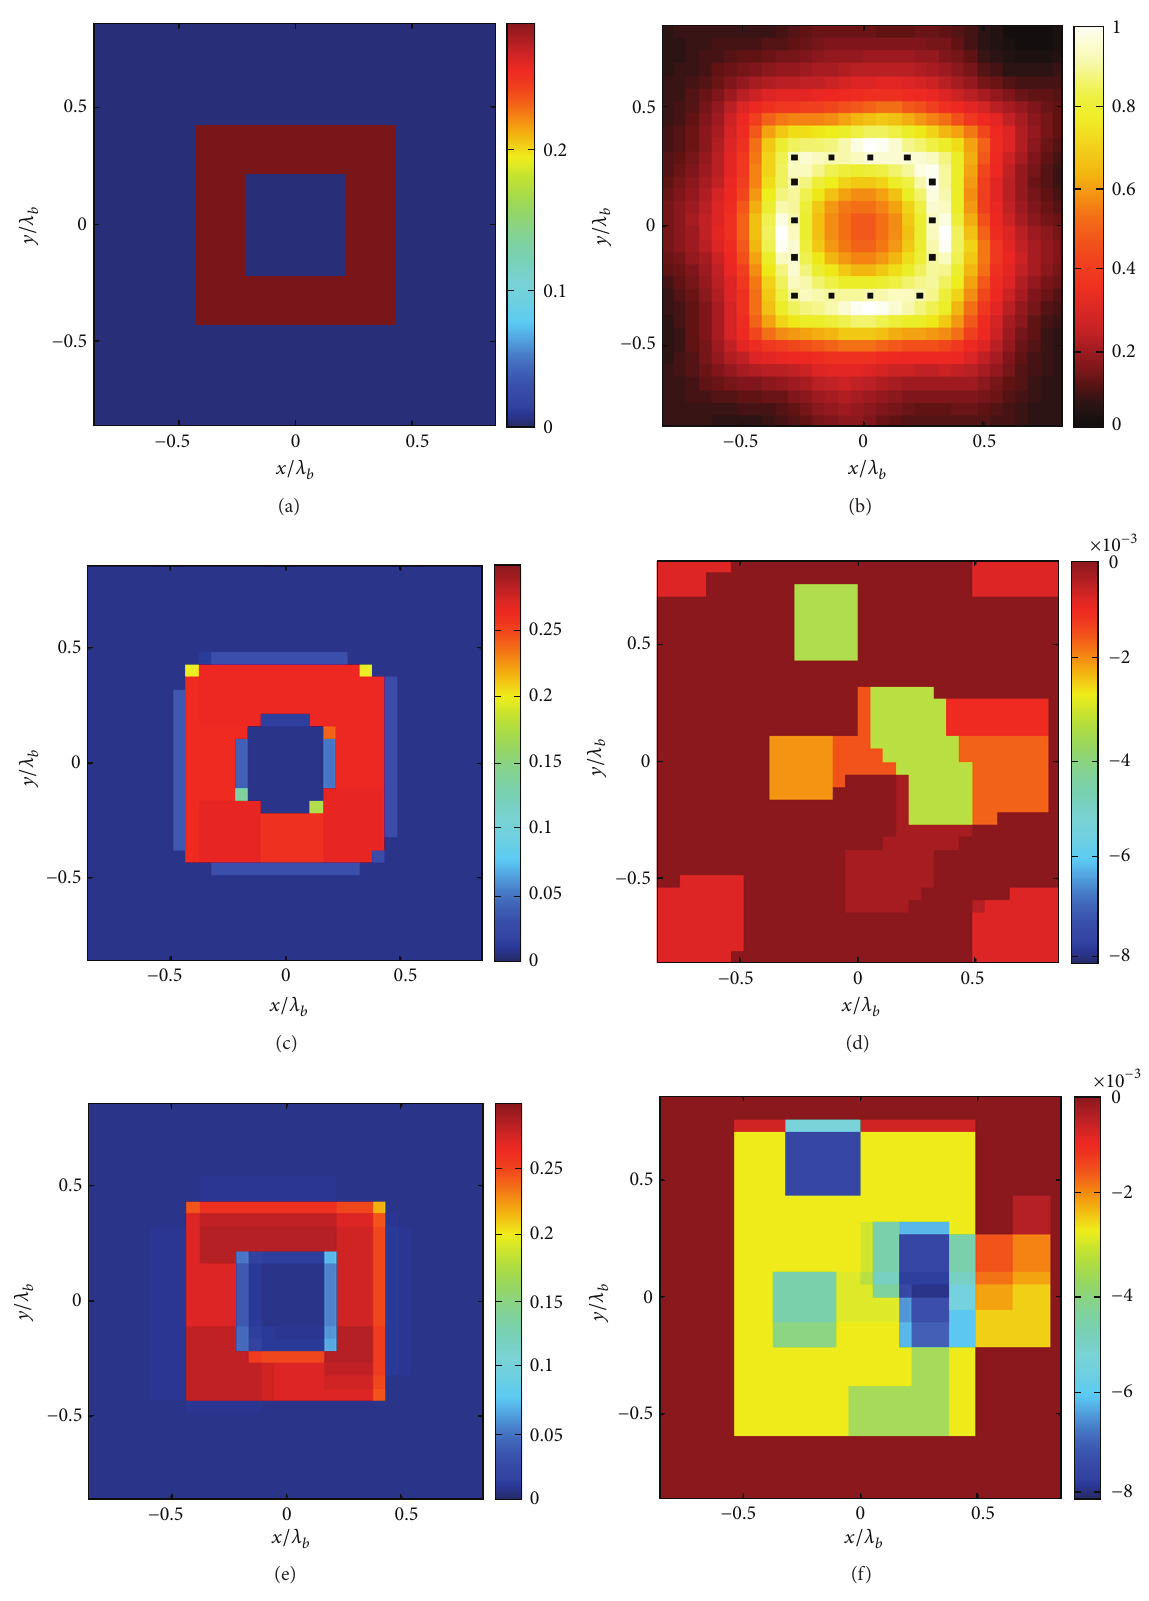
Figure 4: The ring square example. (a) Real part of the contrast reference profile. (b) Normalized logarithmic LSM indicator with the selected pivotpointssuperimposedasdots.Theretrievedprofilebymeansoftheapproach(4) ( 𝛿 = 0.072‖ b ‖ ℓ part. The retrieved profile by means of the approach (6) ( 𝛿 = 0.072‖ b ‖ ℓ